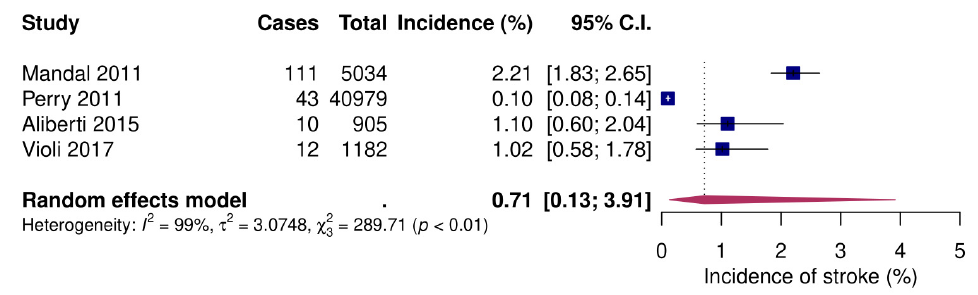
Figure 6. Forest plot of incident stroke of inpatients after community-acquired pneumonia. CI: confidence interval.